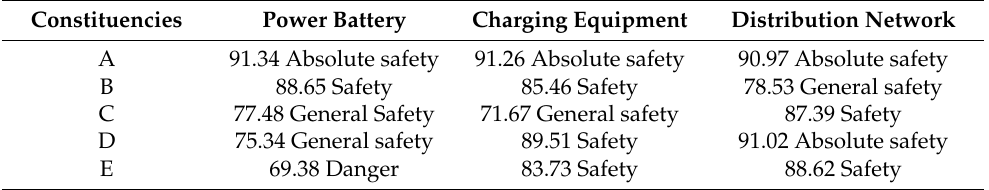
Table 5. GA based evaluation results of the BP neural network.